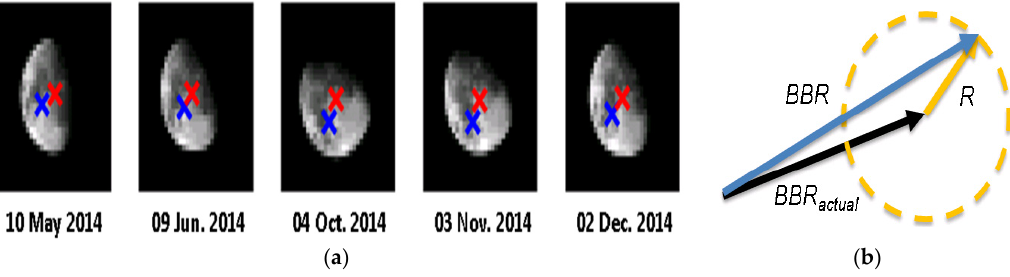
Figure 4. ( a ) VIIRS Band I1 lunar images of the center scans of a few lunar calibration events. Blue and red crosses illustrate the estimated positions of the centroids of two bands; ( b ) a sketch that shows how the measured BBR varies with the rotation of the centroid displacement vector.